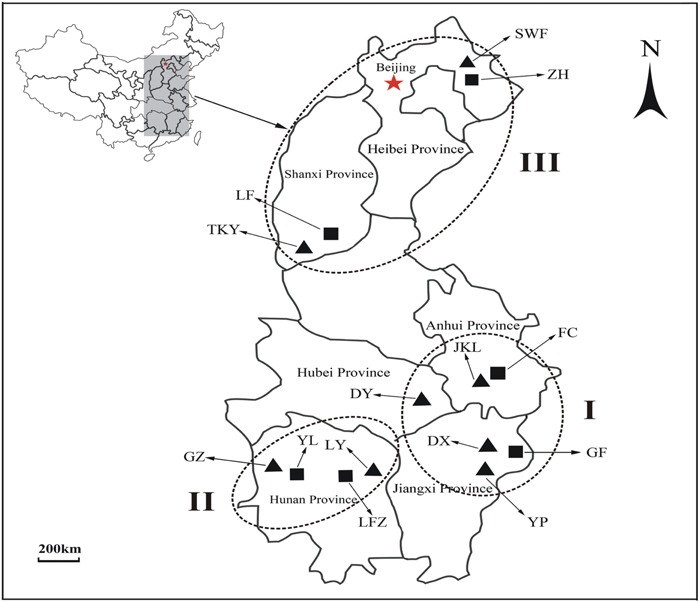
The geographical locations of 14 Commelina communis populations in this study. ▲ Metalliferous populations of C. communis; ■ non-metalliferous populations of C. communis. I, II, and III represent three different sampling groups.